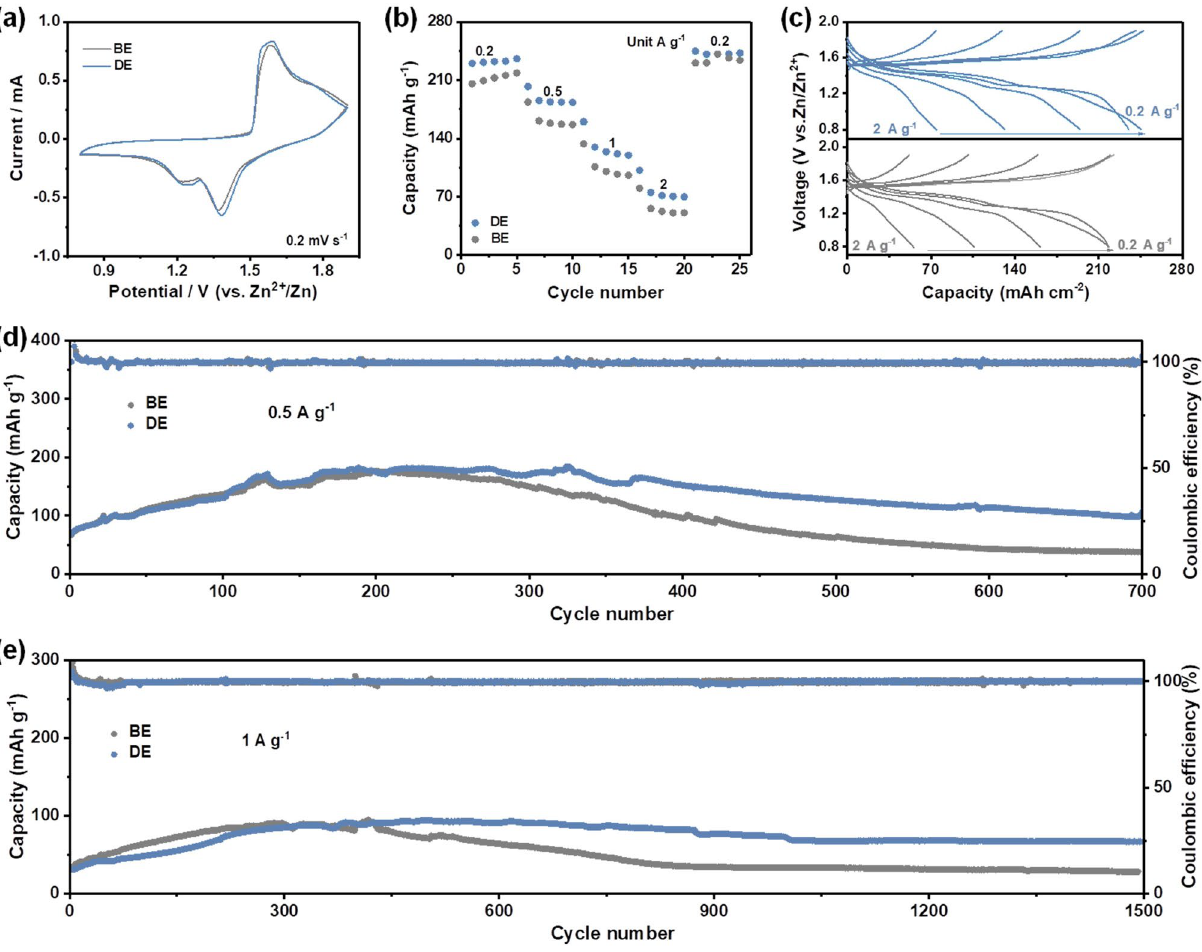
Fig. 5 Electrochemical performances of Zn//MnO 2 full cells. a Comparison of CV curves. b Comparison of rate performances. c Corresponding voltage profiles. d Cycling performance at 0.5 A g −1 . e Cycling performance at 1 A g